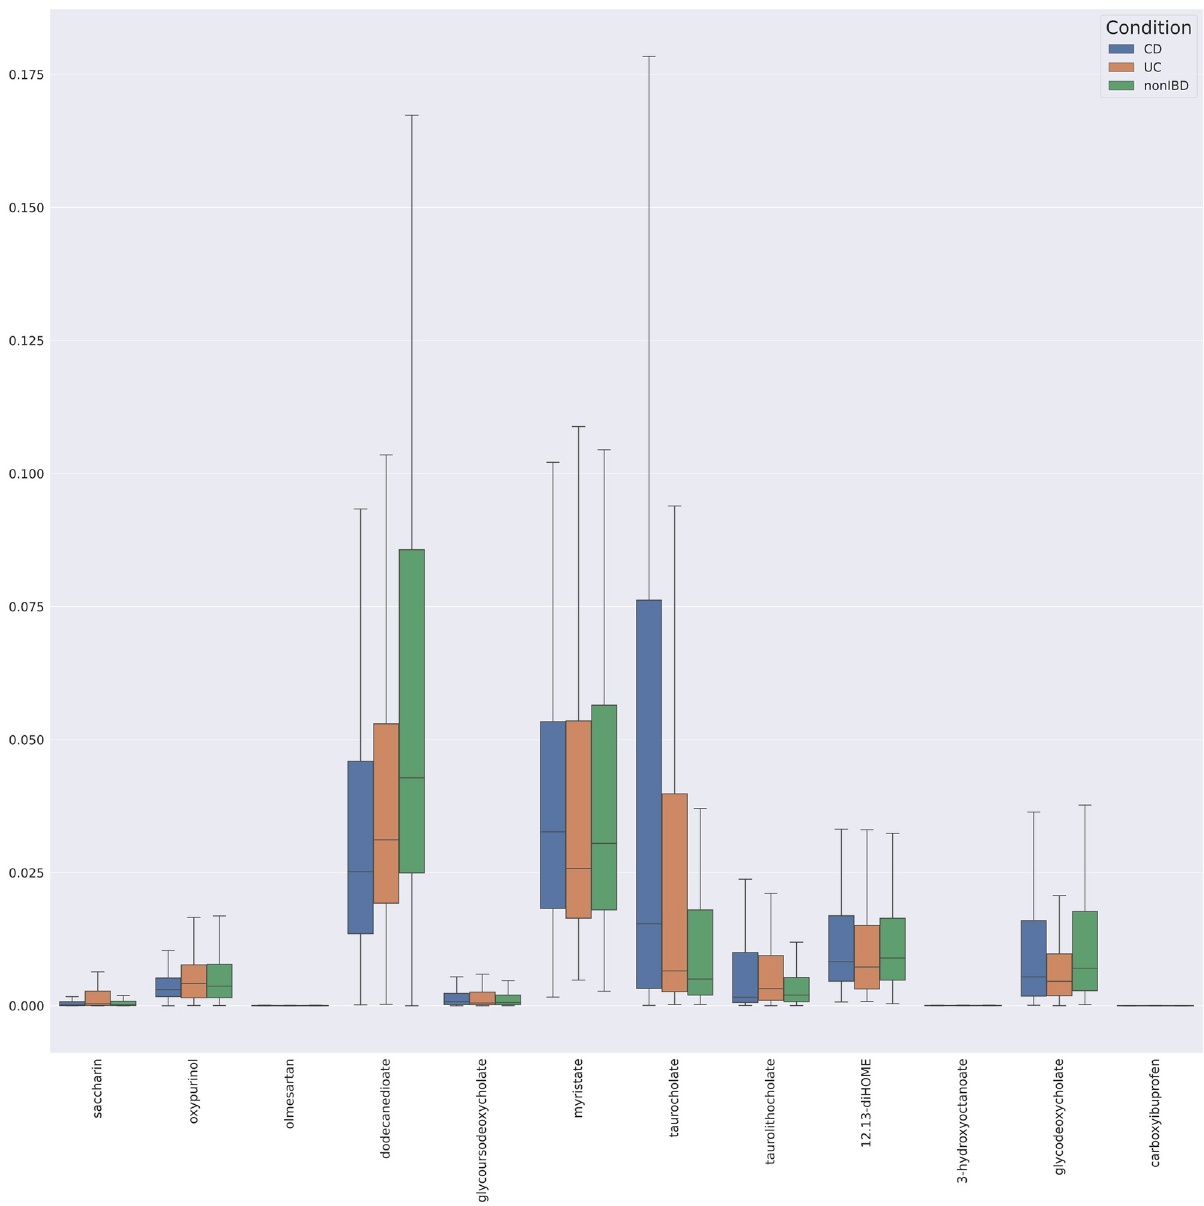
Fig 5. Boxplot of metabolites identified as important by knockoff filtering but do not pass a p-value filter. CD expression shown in blue, UC in Orange and non-IBD in Green.